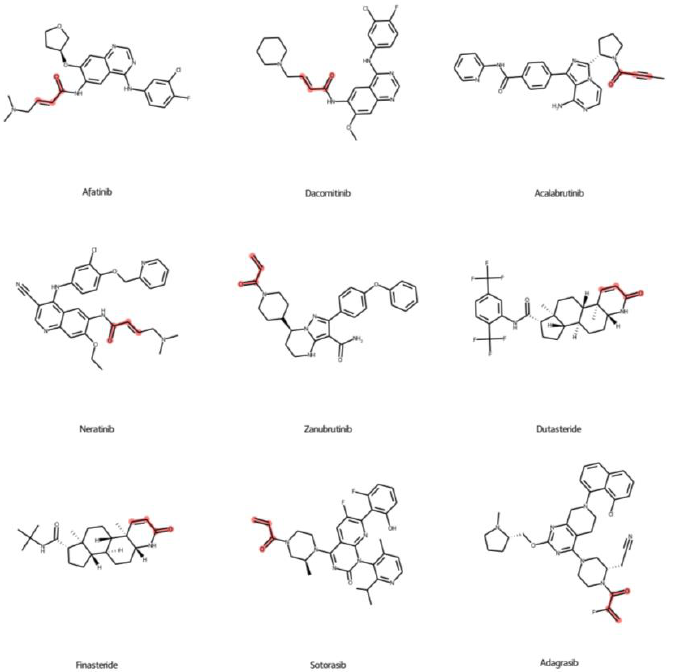
Figure 7. Predicted active compounds with a Michael covalent warhead group. The covalent war- head groups are highlighted in red color. The sotorasib and adagrasib are approved FDA KRAS G12C inhibitors.